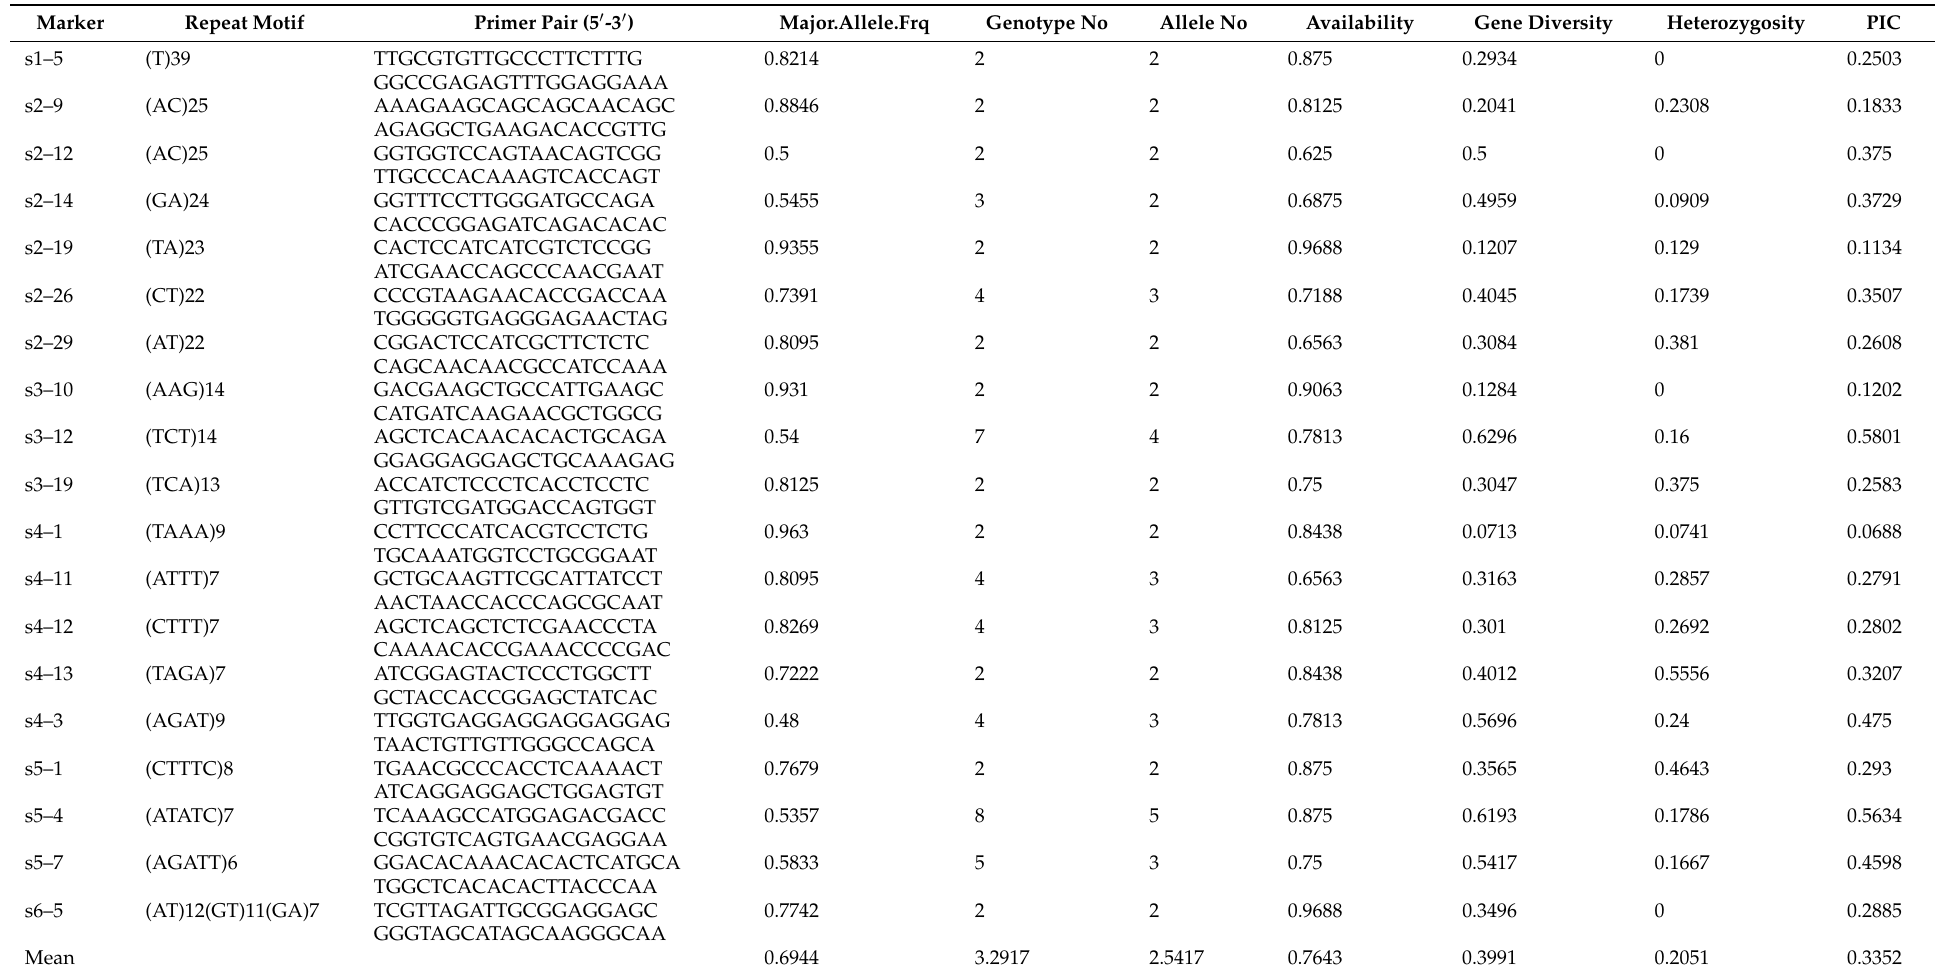
Table 3. Characteristics of 24 SSR primers that amplified successfully and exhibited polymorphism in Chinese